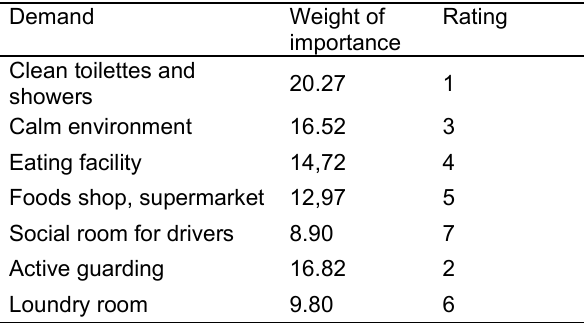
Table 1. Demands of drivers on car park´s facilities.